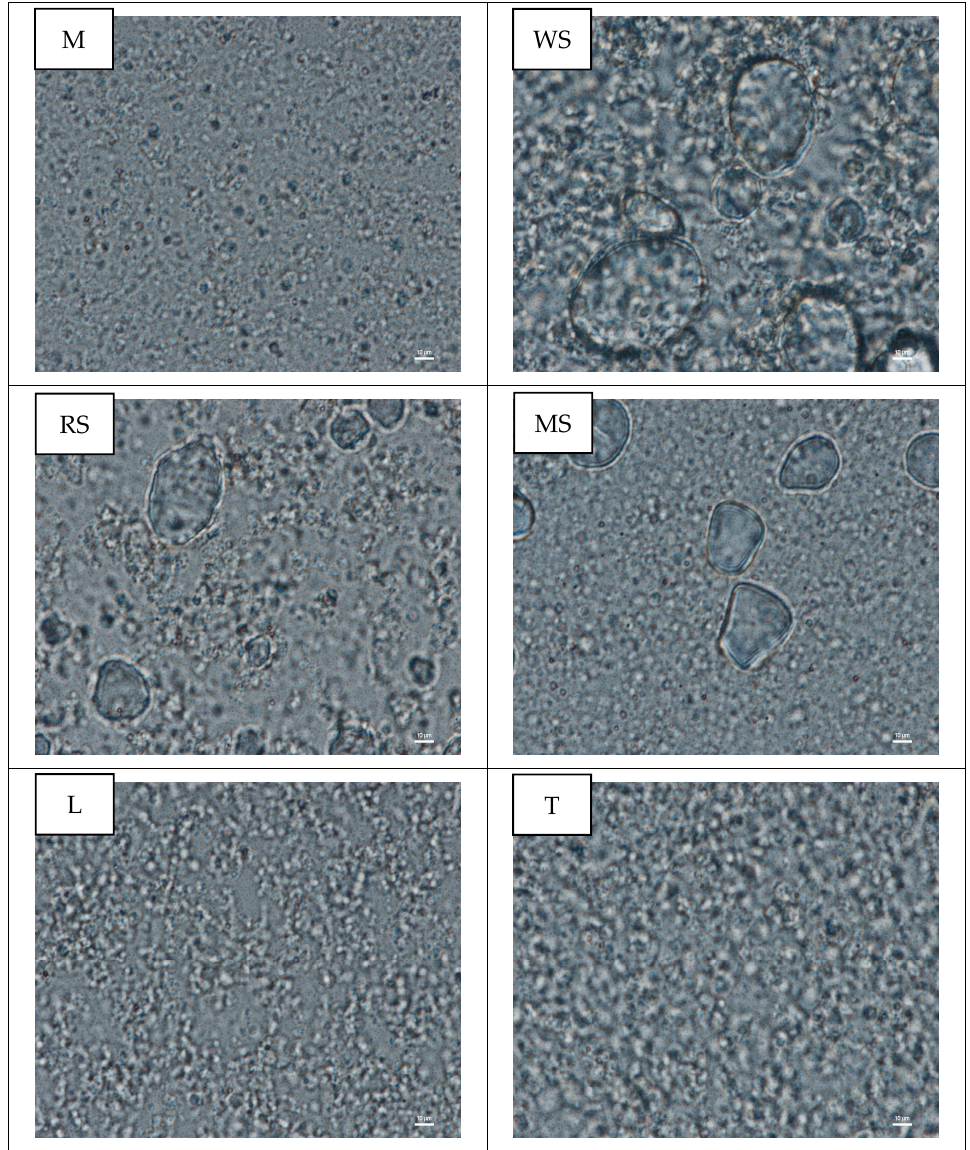
Figure 3. Confocal microscope images of emulsions prepared with pumpkin oil and carbohydrate materials: maltodextrin (M), wheat starch (WS), rice starch (RS), maize starch (MS), lactose (L) and trehalose (T).